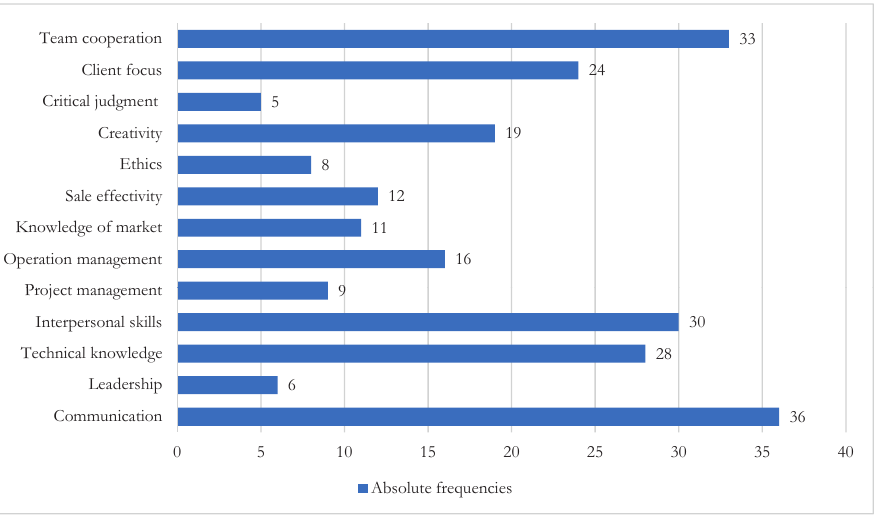
Fig. 2 – Evaluated competencies in the Czech Republic. Source: The survey Note: interpersonal skills = employee’s ability to get along with others while getting the job done; leadership = a process of social influence in which a person can enlist the aid and support of others in the accomplishment